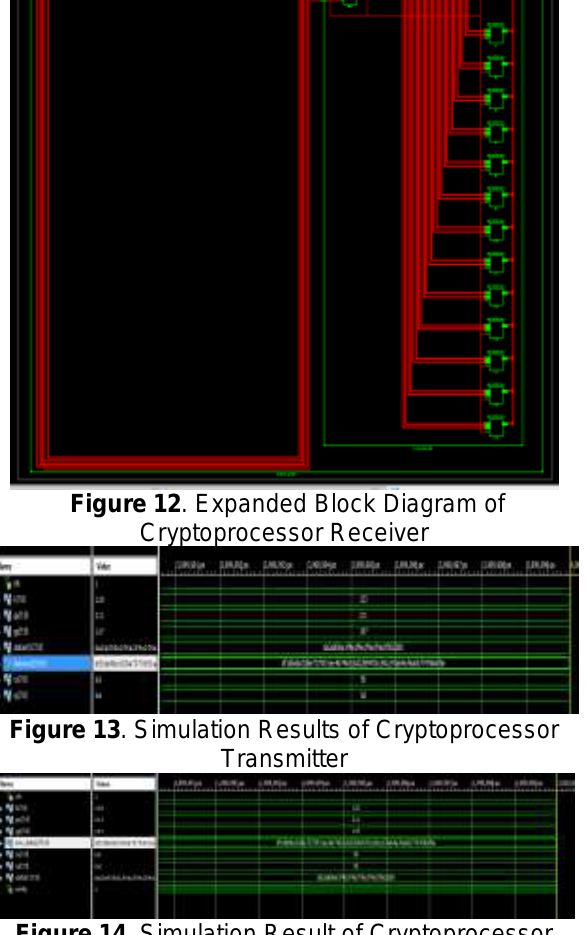
Figure 14 . Simulation Result of Cryptoprocessor Receiver